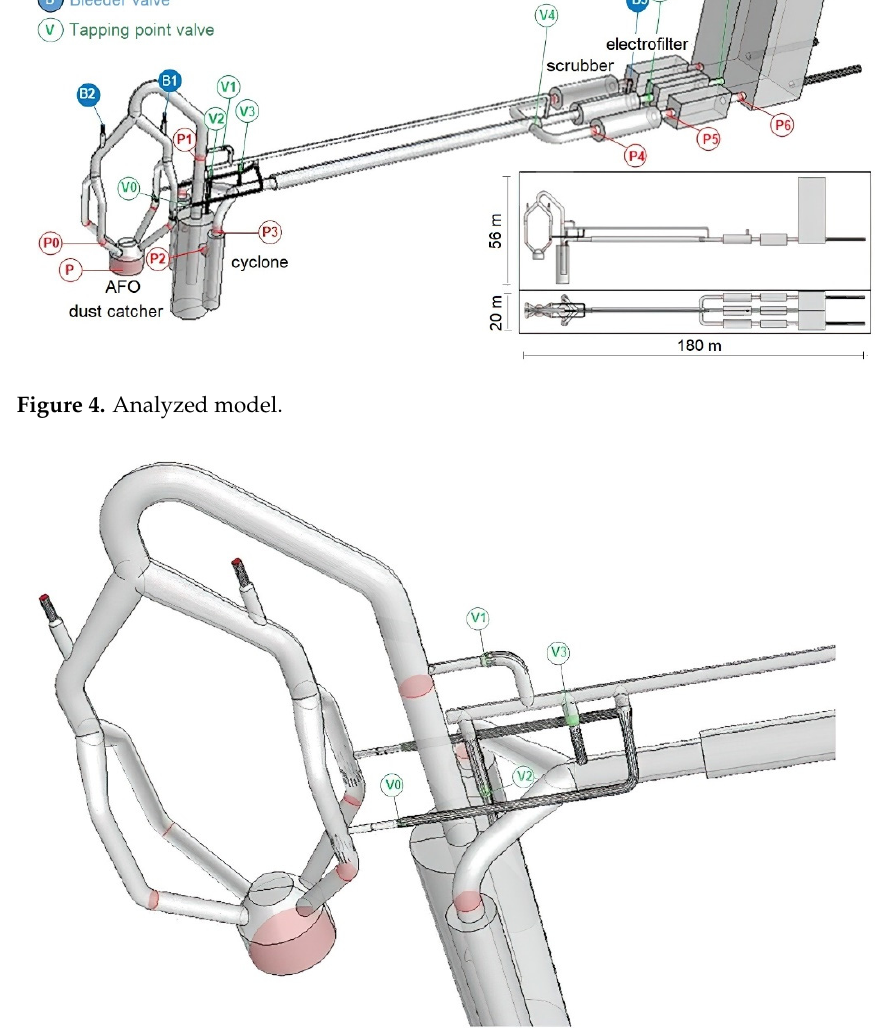
Figure 5. Detail of the analyzed model. The tapping points are: V0, the blast furnace outlet; V1, the dust catcher inlet; V2, cyclone inlet; V3, cyclone outlet.